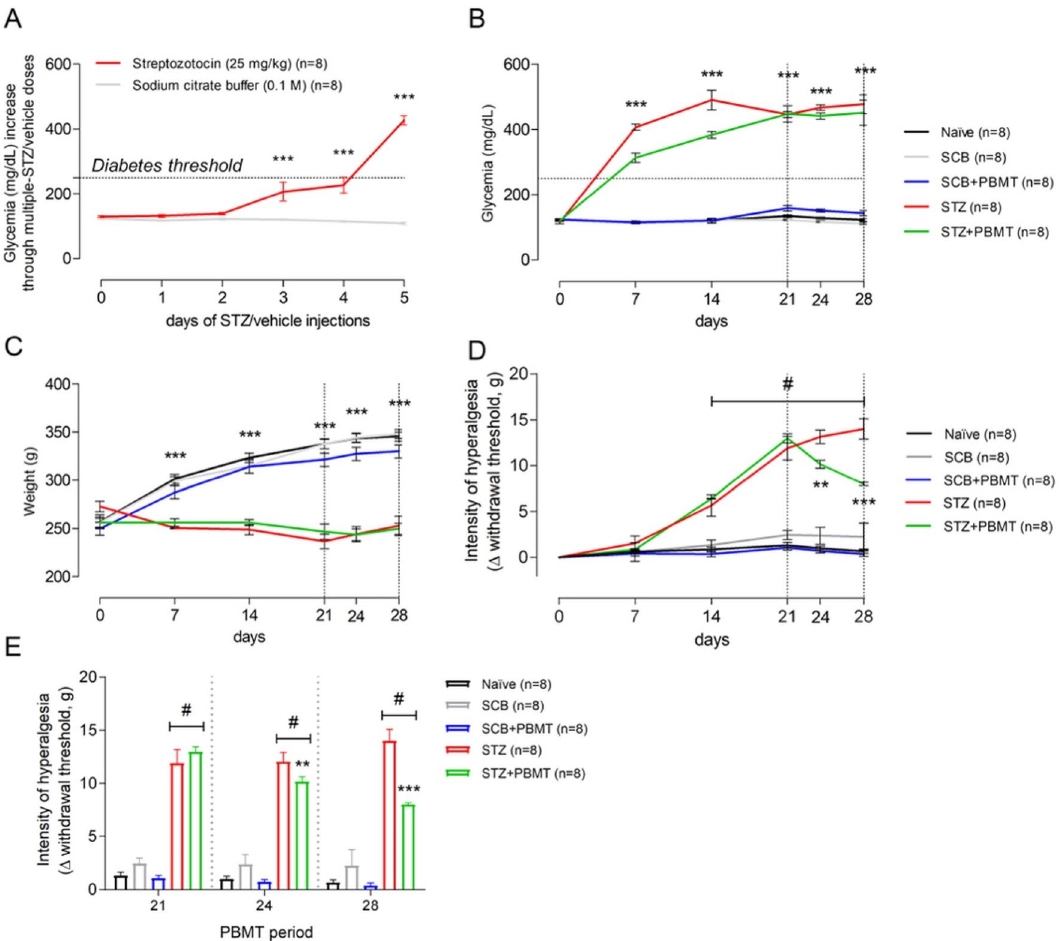
Figure 1. PBMT decreases the hyperalgesia of T1D rats without changing their glycemia or weight. ( A ) Average morning glycemia (red line) from rats during the protocol of T1D induction by multiple STZ low-doses; dotted horizontal black line: established diabetes threshold (glucose ≥ 250 mg/dL). ( B ) Rats from STZ (red line) and STZ + PBMT (green line) groups showed high levels of hyperglycemia at 7, 14, 21, 24, and 28 days. ( C ) Rats from STZ (red line) and STZ + PBMT (green line) groups stopped gaining weight after the installation of diabetes. ( D ) Data from mechanical withdrawal thresholds (Δ; g; the intensity of hyperalgesia) show that PBMT reduced significantly the intensity of hyperalgesia of the STZ + PBMT group (green line) in comparison with the STZ group (red line), at the 24th and the 28th days. ( E ) Bar graph emphasizing the PBMT anti-hyperalgesic effect during the period comprised between the 21st and the 28th days. In ( A – C ), symbol (***) means a significant difference (p < 0.001) between diabetic groups and controls (Two-way ANOVA followed by Bonferroni posthoc test). In ( D ) and ( E ), symbols (**) and (***) mean significant difference (p < 0.01 and p < 0.001, respectively) between STZ and STZ + PBMT groups (Two-way ANOVA followed by Bonferroni posthoc test); symbol (#) means significant difference (p < 0.001) between STZ-induced groups in comparison to control groups (Two- way ANOVA followed by Bonferroni posthoc test [ D ]; One-way ANOVA followed by Bonferroni posthoc test [ E ]). Data are expressed as mean ± S.E.M.; vertical dotted black lines indicate the PBMT